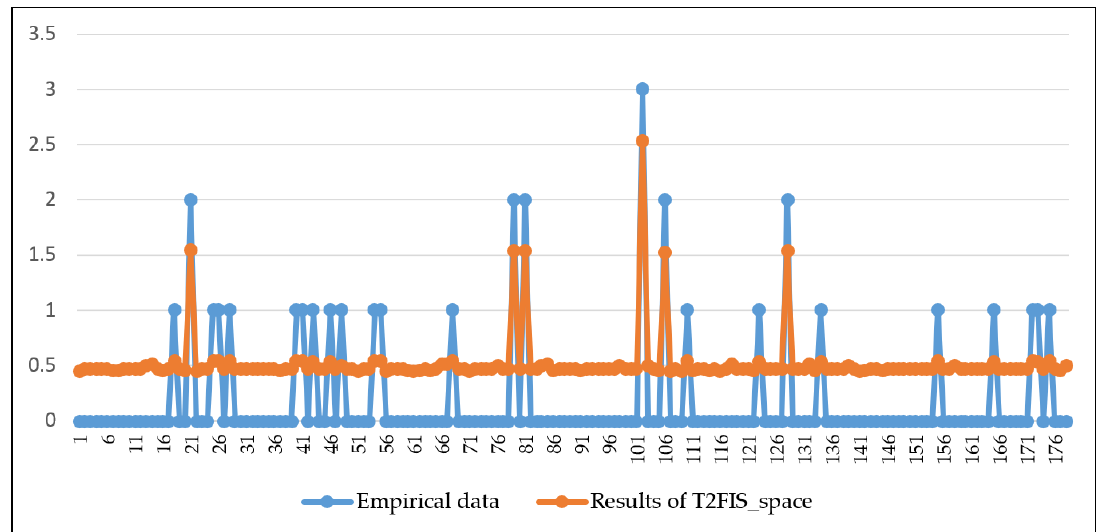
Figure 12. A comparison of empirical data and results of T2FIS in the case of space capabilities assessment—T2FIS_space.